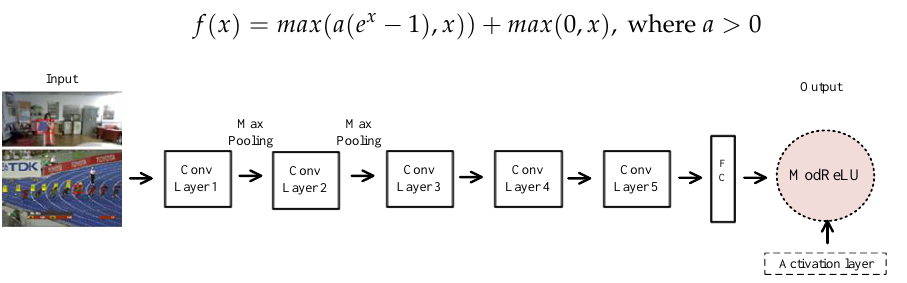
Figure 8. Illustration of our proposed ModReLU activation.